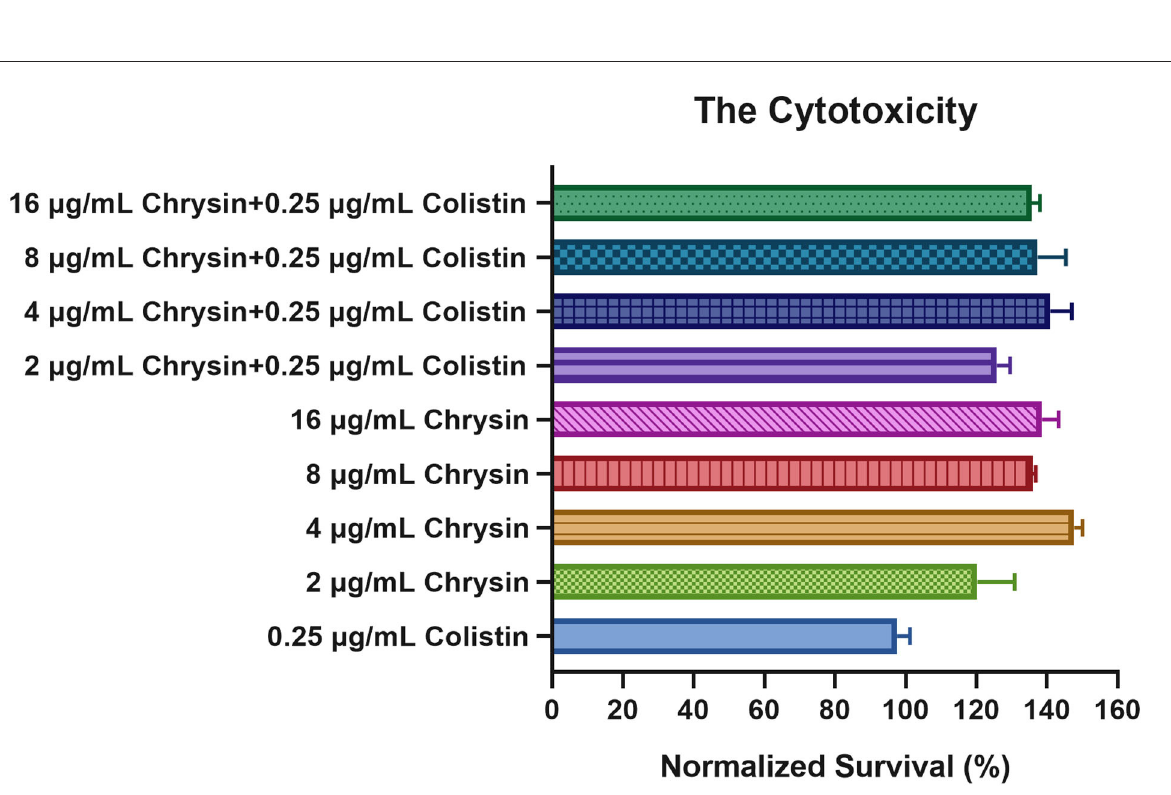
FIGURE3 The cytotoxic effect of chrysin alone and in combination with different concentrations against the RAW 264.7 murine macrophage cell line. Data are expressed as the mean ± SD of three